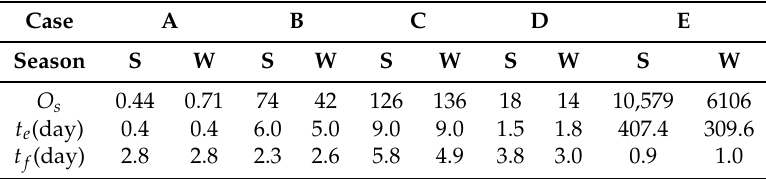
Table A1. Estimation of rotational effects. S is summer, W is